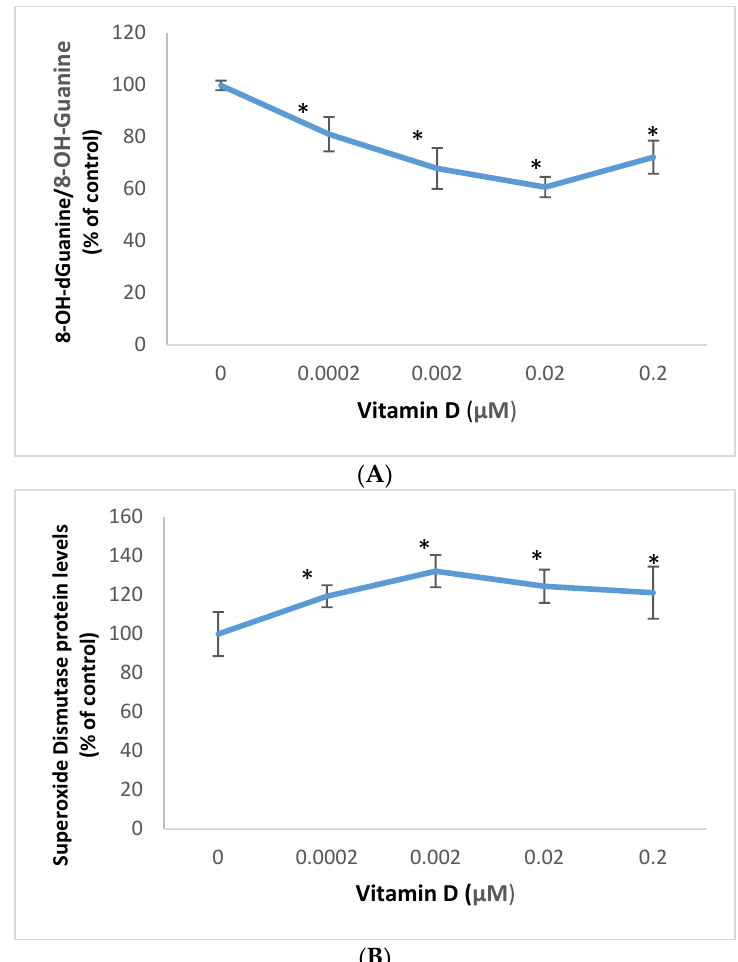
Figure 1. Effect of 1 ,25-dihydroxyvitamin D3 (vitamin D) on 8-OH-dGuanine/8-OH-Guanine (oxidative DNA/RNA damage) ( A ), and superoxide dismutase protein levels ( B ) in melanoma cells; error bars: standard deviation, n = 4; * = p < 0.05, relative to control.